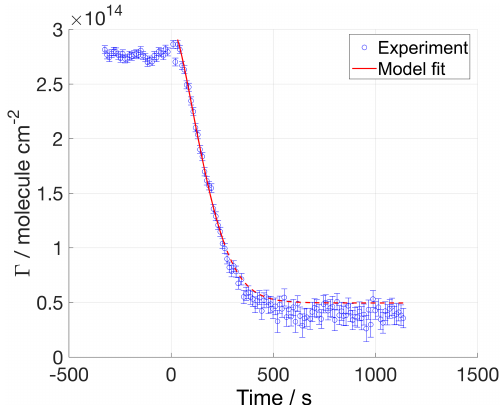
Figure 7. Palmitoleic acid ( d 14 POA) exposed to [NO 3 ] = 86ppt. The red line illustrates the fit obtained from our kinetic modelling (the solid section of the line indicates the data range used for the Figure 5. The experimental data for d 34 OA exposed to [NO 3 ] = kinetic analysis; the dashed section of the model line illustrates the 86ppt are shown with the best fit in red. The desorption lifetimes calculated final part of the decay, but the corresponding experimen- for NO 3 and NO 2 have selectively been modified in this sensitiv- tal data were not used in the optimisation of the ity study to show their effect on the modelled surface excess de- (cid:1) = τ d, cay. Condition 1 refers to (cid:0) τ d, NO NO 3 , 2 , and hence best fit 3 , 1 (cid:0) τ (cid:1) = = 1 τ d, NO . Condition 2 refers to τ d, NO d, NO 3 , 2 6 best fit 3 , 1 3 , 2 (cid:0) τ (cid:1) (cid:1) = 6 (cid:0) τ d, , and hence τ d, NO . Condi- d, NO 3 , 2 NO 3 , 1 best fit best fit 3 , 1 = 10 − 4 ( τ d, tion 3 refers to τ d, NO NO 2 ) best fit . Condition 4 refers 2 = 15 ( τ d, to τ d, NO NO 2 ) best fit . 2